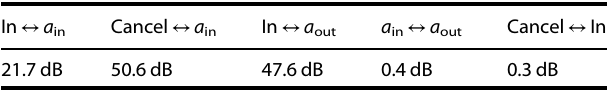
Table 2. Parameters for the directional coupler.